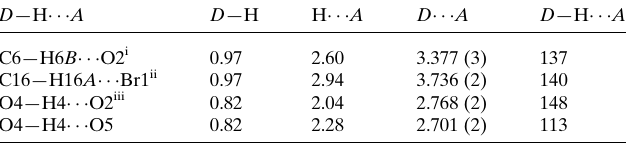
Table 1 Hydrogen-bond geometry (A˚ , (cid:2) ).